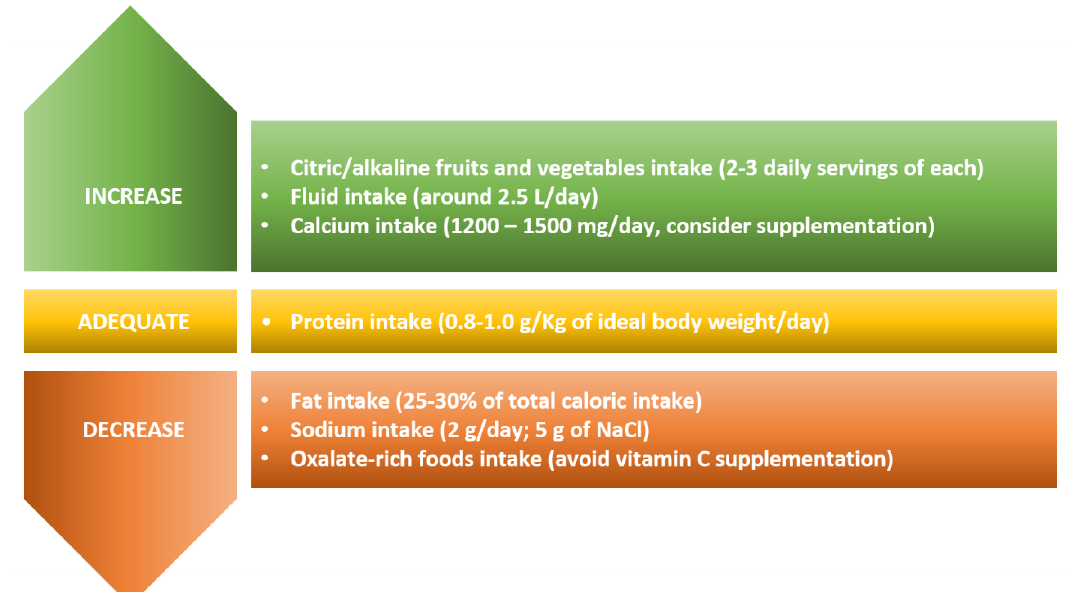
Figure 2. Dietary recommendations for BS patients to prevent the risk of stone formation and